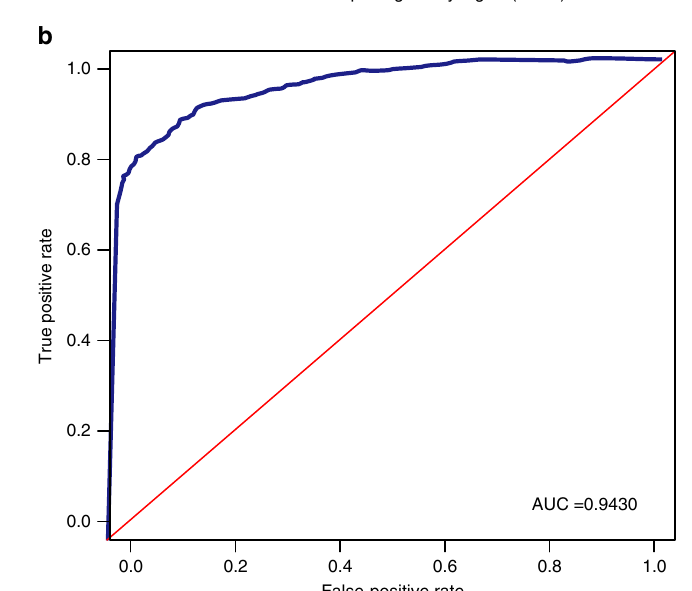
Fig. 2 Identi fi cation of URLs in a simulation study. a Each subplot corresponds to a target gene, in which the x -axis represents all 66 URLs, and the y -axis represents the predicted probabilities of the URLs (normalized by dividing with the largest value), as illustrated in small white circles ‘ ○ ’ . The true regulatory logics are marked with green circles, while the predicted logics are marked with red squares. It can be seen that LogicTRN correctly identi fi es the regulatory logics for fi ve of six genes. b ROC curve and AUC of network reconstruction in the simulation study. The average ROC curve and its dynamic range are obtained from 1000 runs with random settings in each run. The red line represents the performance of random